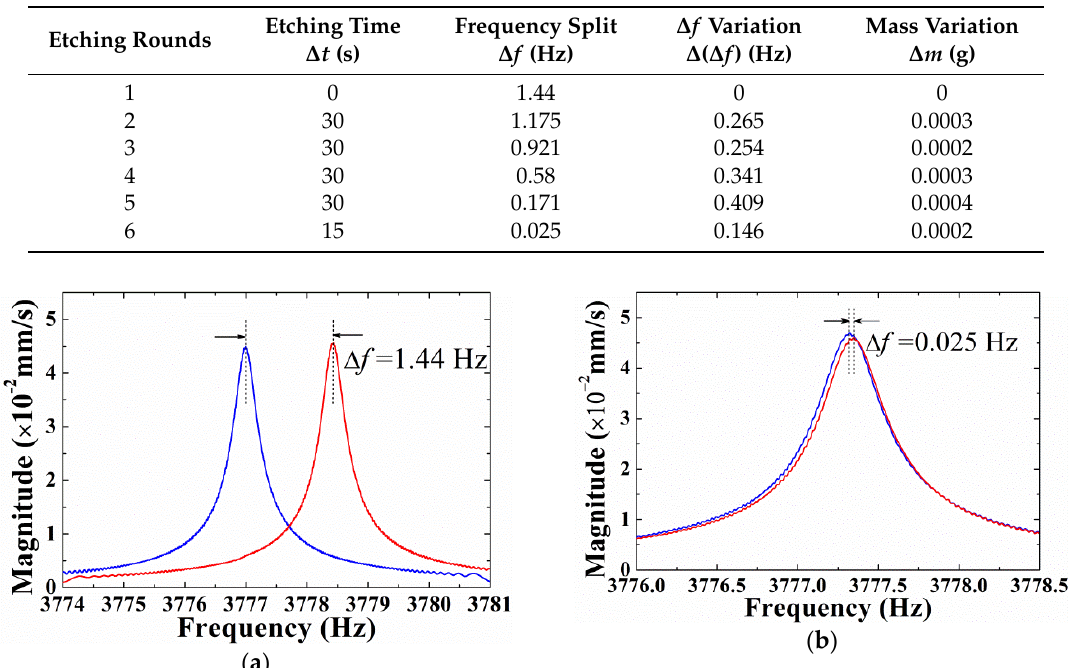
Table 2. The frequency split and mass change of H02 of each chemical etching.